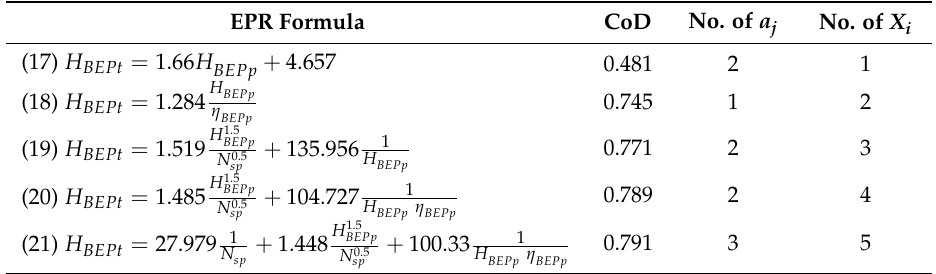
Table 12. Models returned by EPR-MOGA for H BEPt .